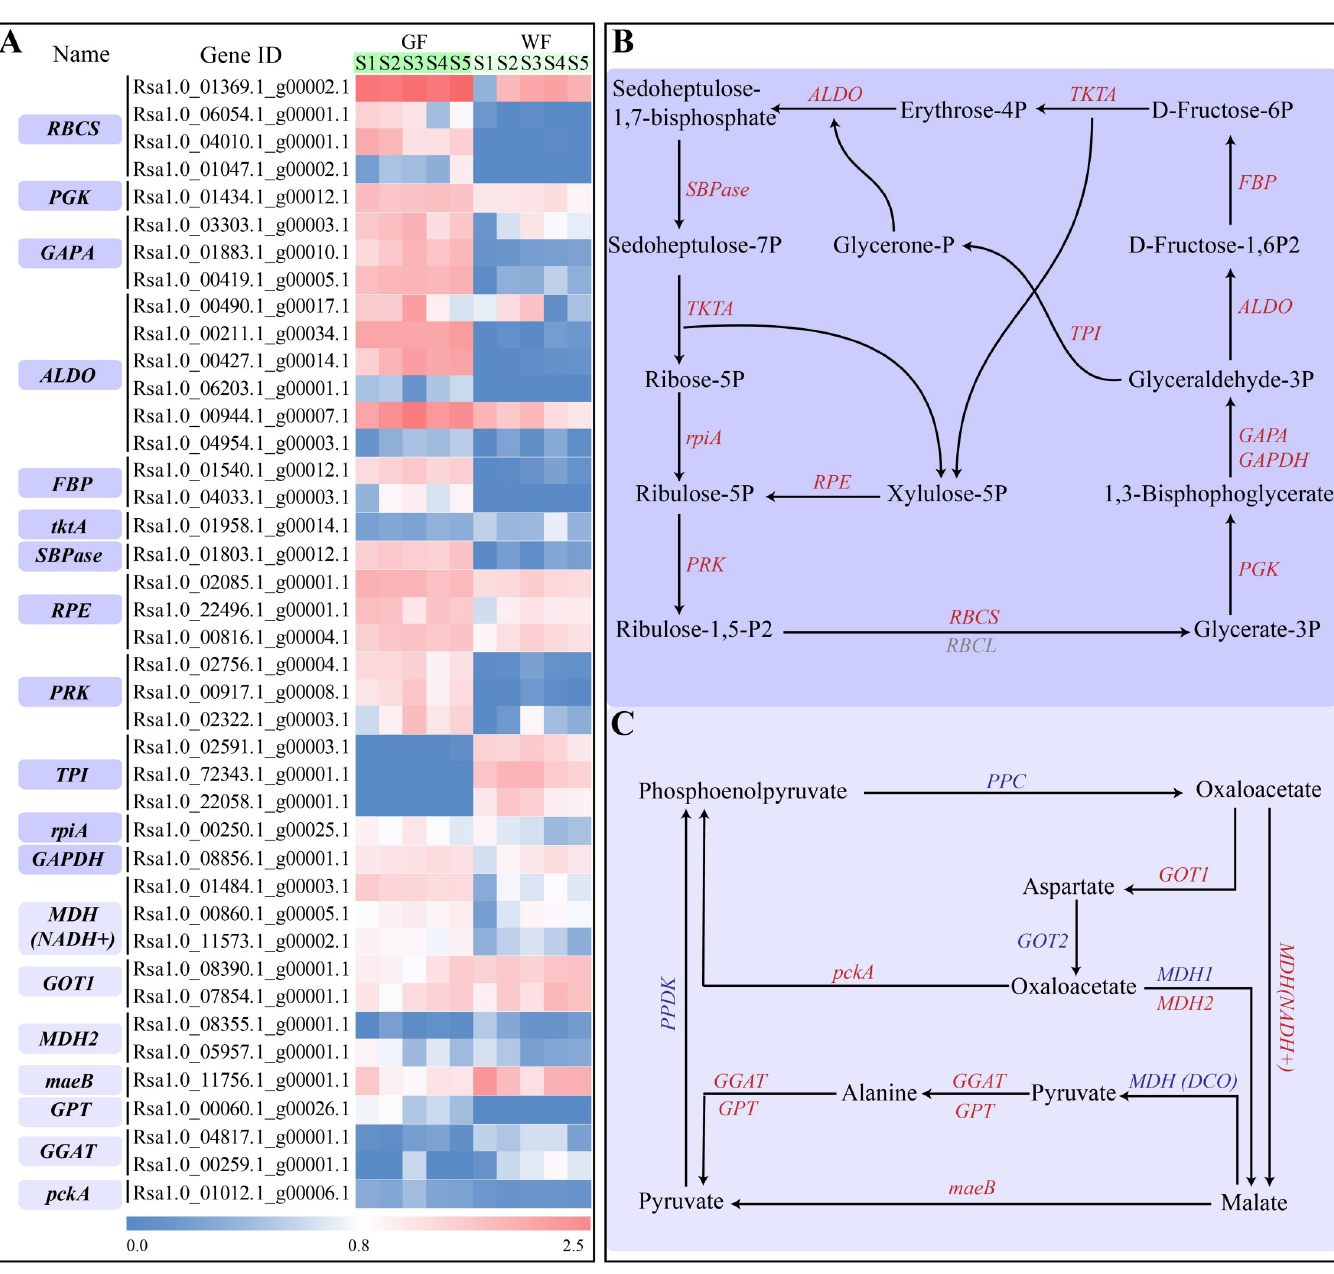
PLOS ONE | https://doi.org/10.1371/journal.pone.0252031 May 27, 2021 13 /